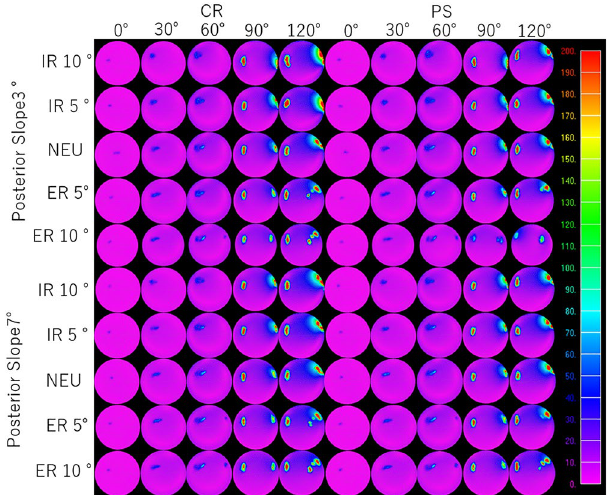
Figure 8. Distribution of von Mises equivalent stresses on the patellofemoral contact surface. CR cruciate- retaining design, PS posterior-stabilized design, IR internal, NEU neutral, ER